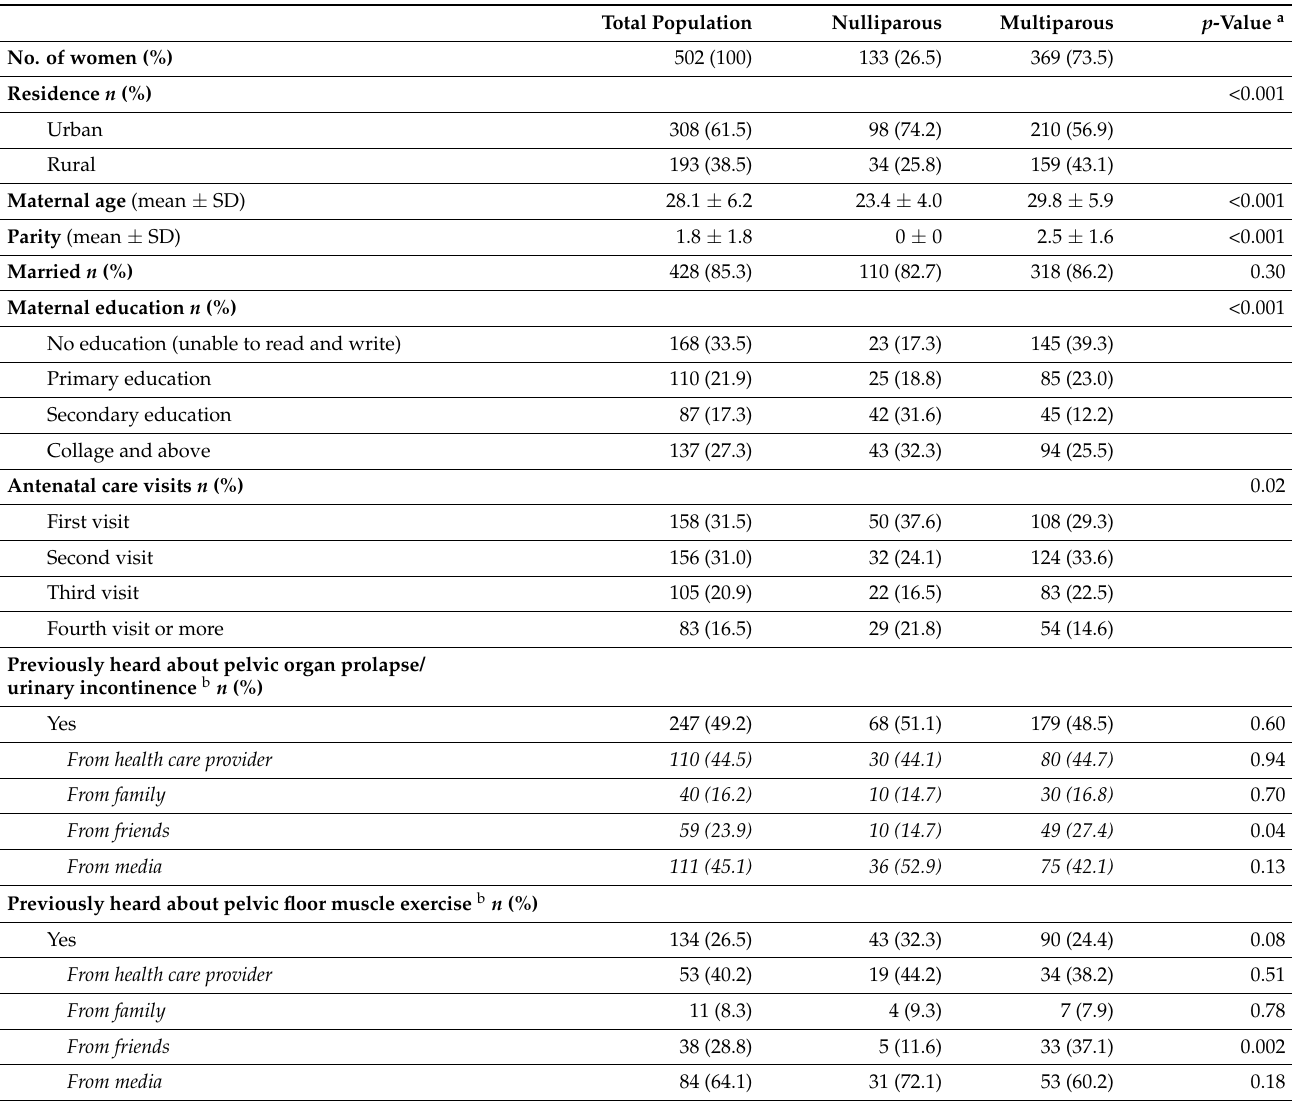
Table 1. Background characteristics for the study population by maternal parity, n = 502. Total Population Nulliparous